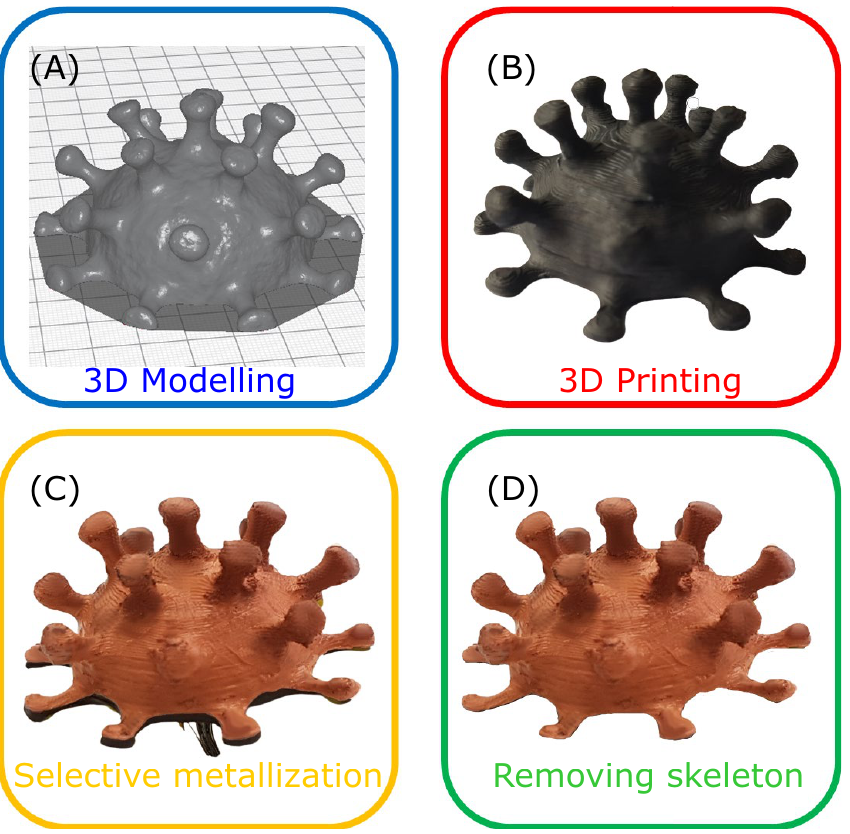
Figure 1. The proposed metal printing—the sequence of a free standing metal coronavirus prototyping. ( A ) 3D-modelling and slicing. ( B ) FDM 3D-printing of a conductive PLA (GPLA) skeleton. ( C ) Electroplating of the prototype’s surface. ( D ) Removal of the plastic